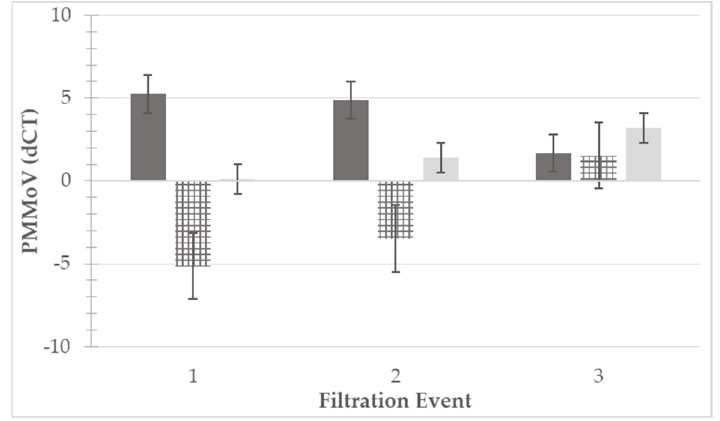
Figure 3. Pepper mild mottle virus (PMMoV) levels detected via RT-qPCR molecular assay. PMMoV levels were quantified for three filtration events in unfiltered (dark gray, left) and filtered (light gray, right) irrigation water. Differences in levels between unfiltered and filtered water from each filtration event are displayed as the dark and light gray hatched bars (center). Quantification was performed using delta cycle threshold (dCT) values, with 40 cycles being the terminal value and the dCT being the difference between the terminal value and the detected value (e.g., CT 32, dCT = 40 − 32 = 8). Higher dCT values represented higher amounts of viral RNA present within the reaction. Standard error bars are presented for each bar.